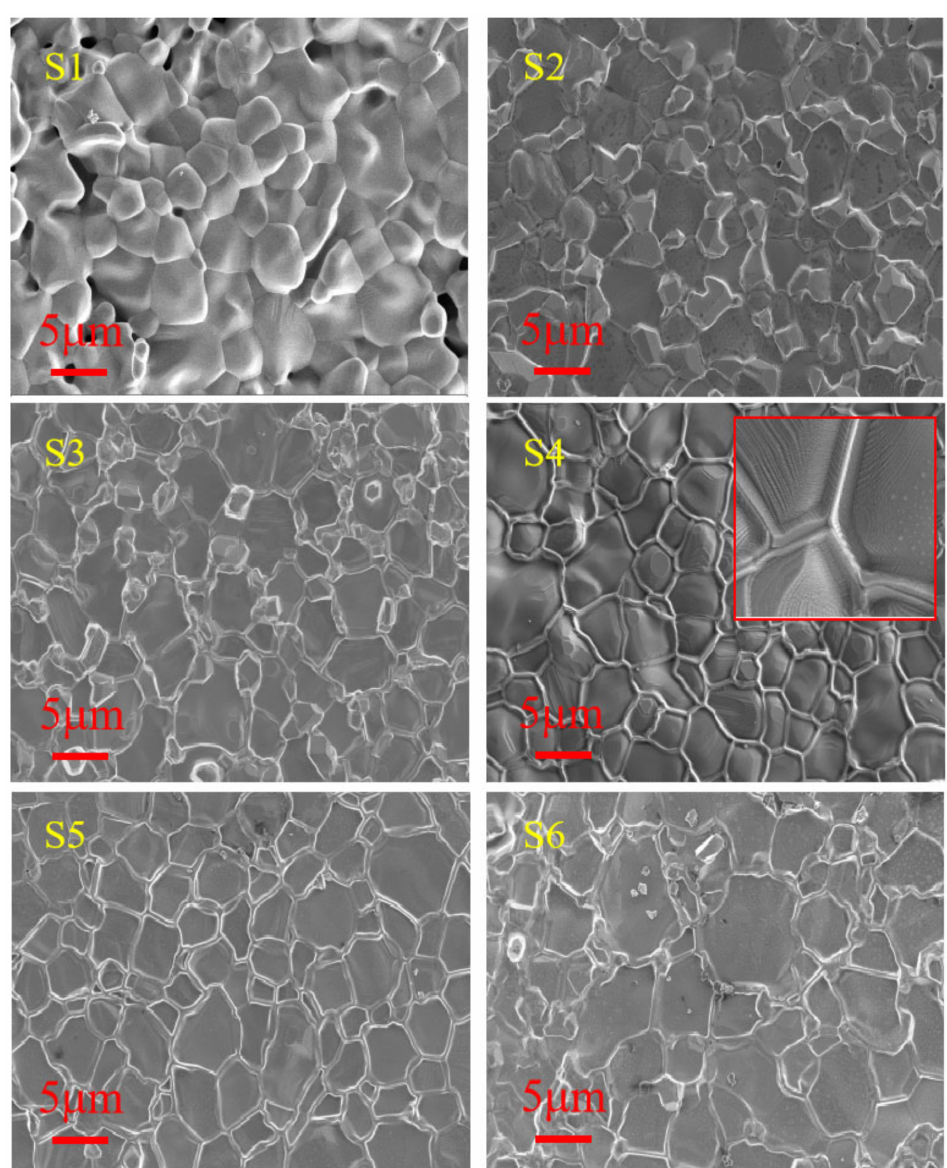
Figure 7. SEM images of the sintered S1~S6 sample